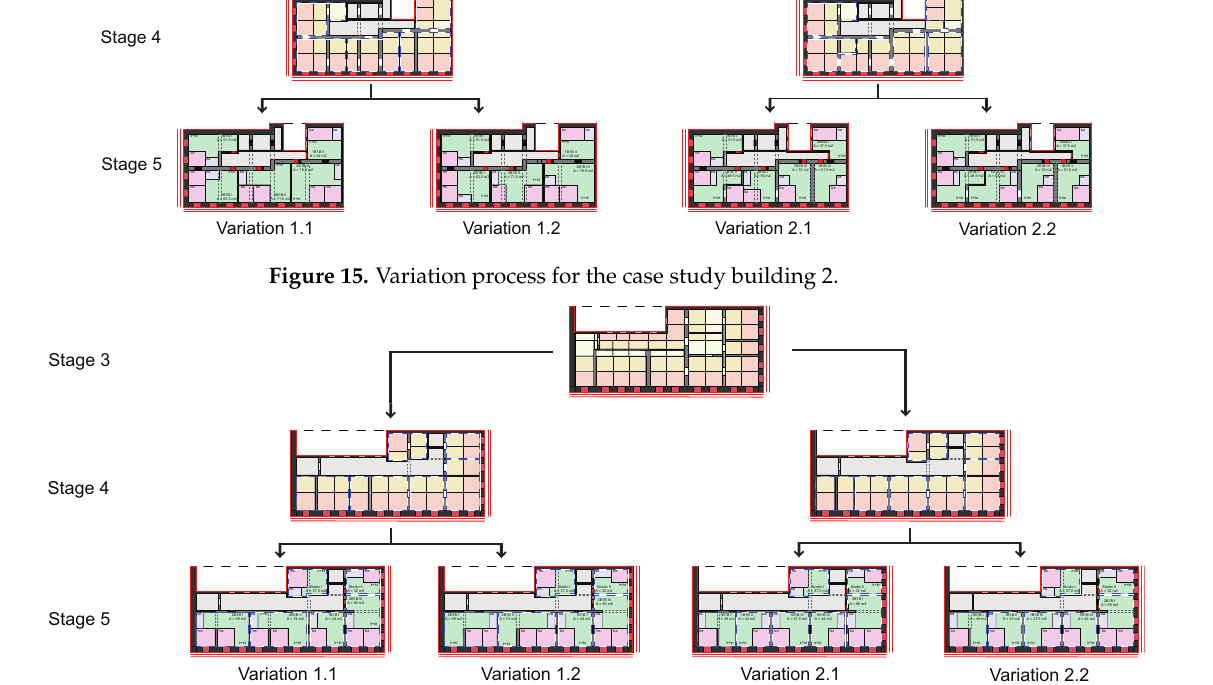
Figure 16. Variation process for the case study building